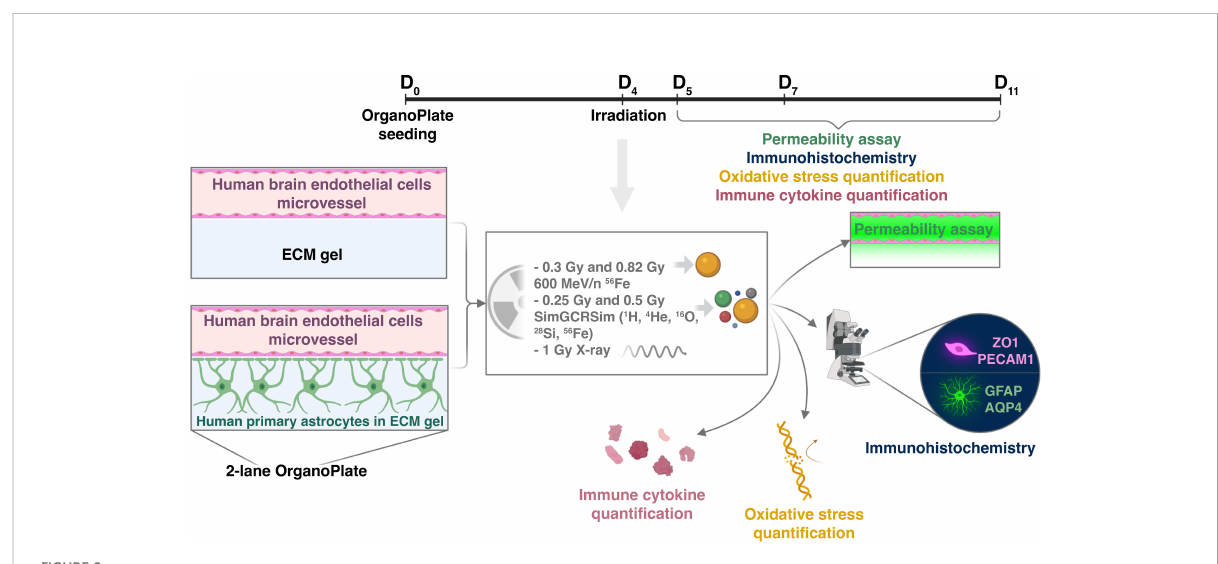
FIGURE 2 Experimental design. (Created with